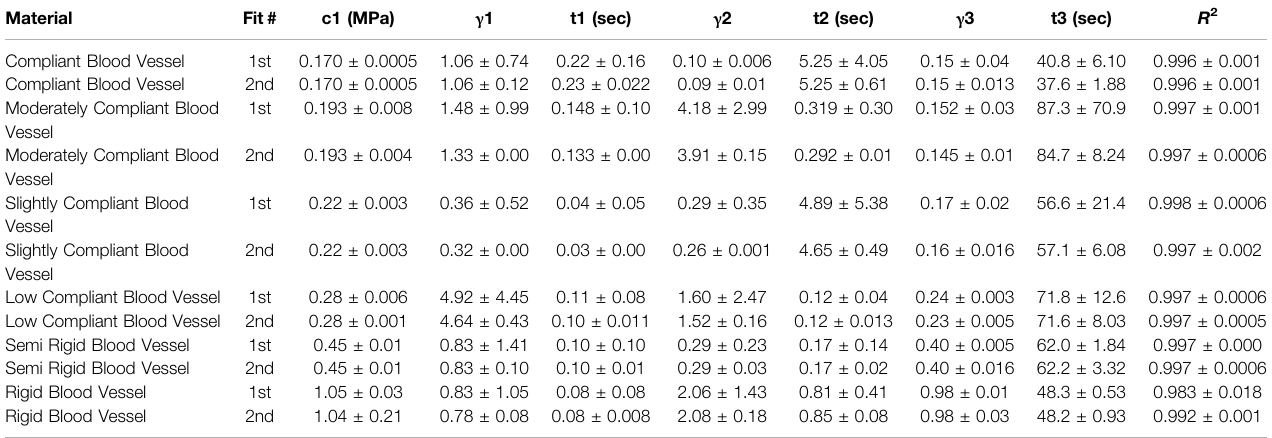
TABLE4| NonlinearviscoelasticincompressibleNeo-Hookean fi ttoJ750DigitalAnatomyPrinter(DAP)BloodVesselMaterials.Tableofcompressiblenonlinearviscoelastic compressibleNeo-HookeanparametersfortheDAP,BloodVesselmaterialsalongwiththe R 2 valuesofthe fi tbetweentheconstitutivemodelandexperimentaldata(n= 6specimenspermaterialexceptforShore30withn=5specimenspermaterial).Coef fi cientSetreferstotheinitialguess( fi rst)withwideboundsontheparametersfollowed by a second optimization run with the bounds being the mean parameters from the fi rst optimization run ±10% of the mean.